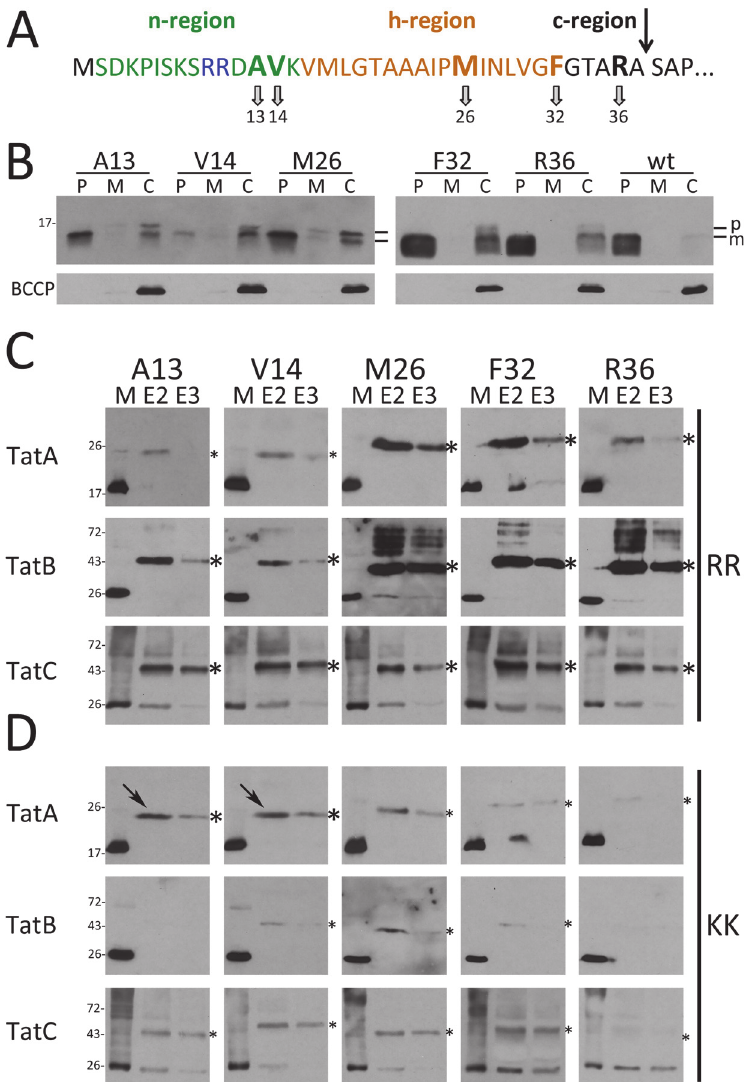
Fig 1. In vivo site-directed cross-linking of Tat signal peptides to the TatABC components. (A) Amino acid sequence and positions of the p Bpa cross-linker in the Tat signal peptide. The arrow indicates the signal peptide cleavage site. (B) Transport of native HiPIP and variants (produced from pEXH5-tac-H6 derivatives) with p Bpa exchanges at indicated positions in pEvol-pBpF/pRK- tatABC -containing strains grown in the presence of 0.1 mM p Bpa. Detection of HiPIP in subcellular fractions by SDS-PAGE/Western-blotting; the cytoplasmic biotin carboxyl carrier protein (BCCP; * 22 kDa) was detected to control periplasmic purity. P: periplasm; M: membrane; C: cytoplasm; p: precursor HiPIP; m: mature HiPIP. (C) In vivo cross-links of twin- arginine signal peptides to Tat translocon components with p Bpa at indicated positions. Specific cross-links are detected in affinity-chromatography elution fractions E2 and E3 by Western blotting using indicated Tat component-specific antibodies. Molecular weight standards are indicated at the left. (D) Effect of cross-links of RR > KK mutated signal peptides with p Bpa exchanges; (strains and conditions in C) and D as in B)). Arrows indicate two TatA-cross-links with unaffected signal intensity. * , strong cross-links; * , weak cross- links; M, solubilized membrane fraction; E, elution